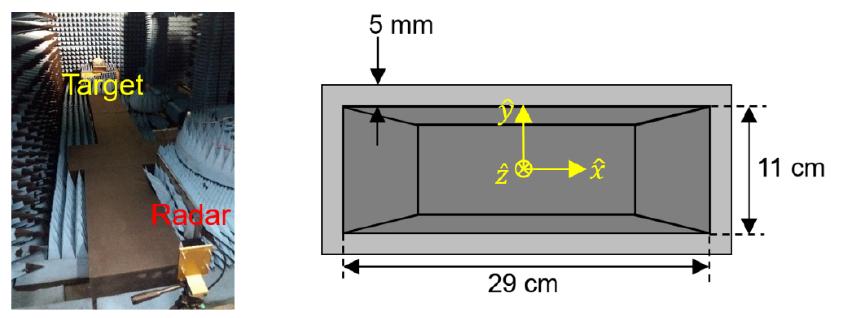
Figure 4. Rectangular open-cavity structure and measurement setup.